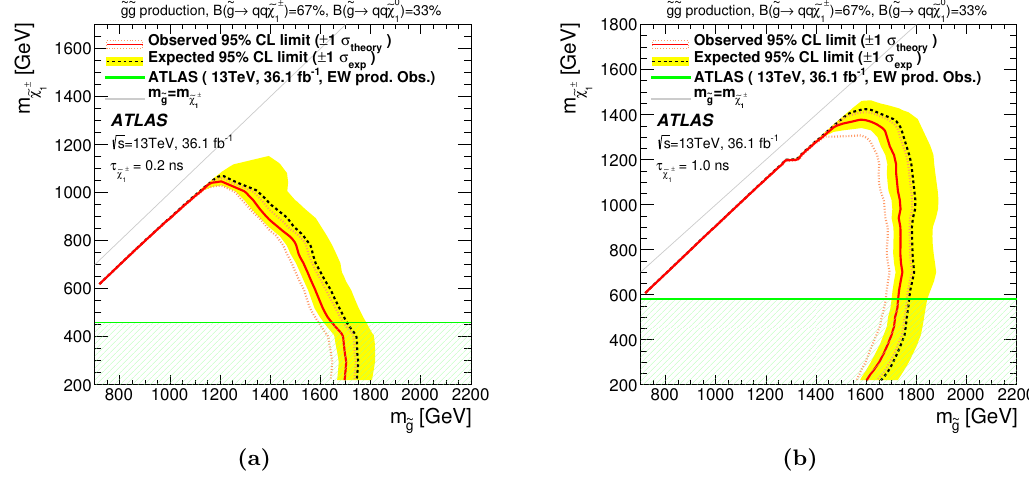
Figure 9 . Exclusion limit at 95% CL obtained in the strong production channel in terms of the gluino and chargino masses. The limit is shown assuming a chargino lifetime of (a) 0.2 ns and (b) 1.0 ns. The yellow band shows the 1 (cid:27) region of the distribution of the expected limits. The median of the expected limits is shown by a dashed line. The red line shows the observed limit and the orange dotted lines around it show the impact on the observed limit of the variation of the nominal signal cross-section by (cid:6) 1 (cid:27) of its theoretical uncertainties. Observed limits in the electroweak production search are shown as a green shaded region.